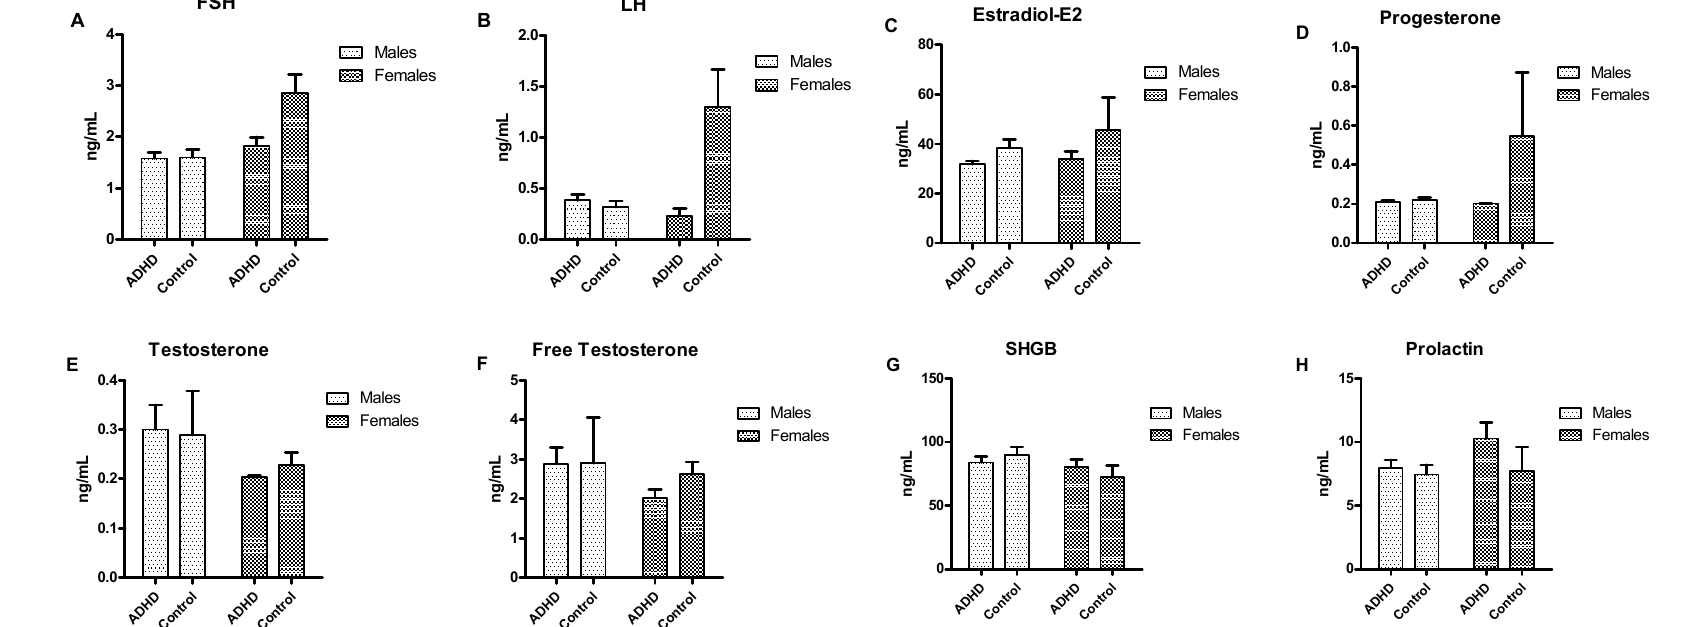
Figure 2. Serum levels of gonadal hormones in boys and girls among patients with ADHD and controls